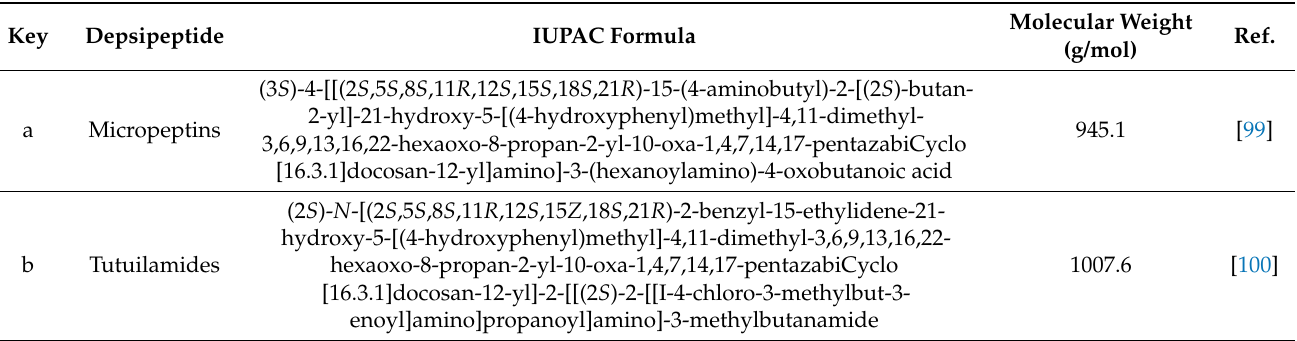
Table 3. Formula and molecular weight of depsipeptides inhibiting elastases in tumor